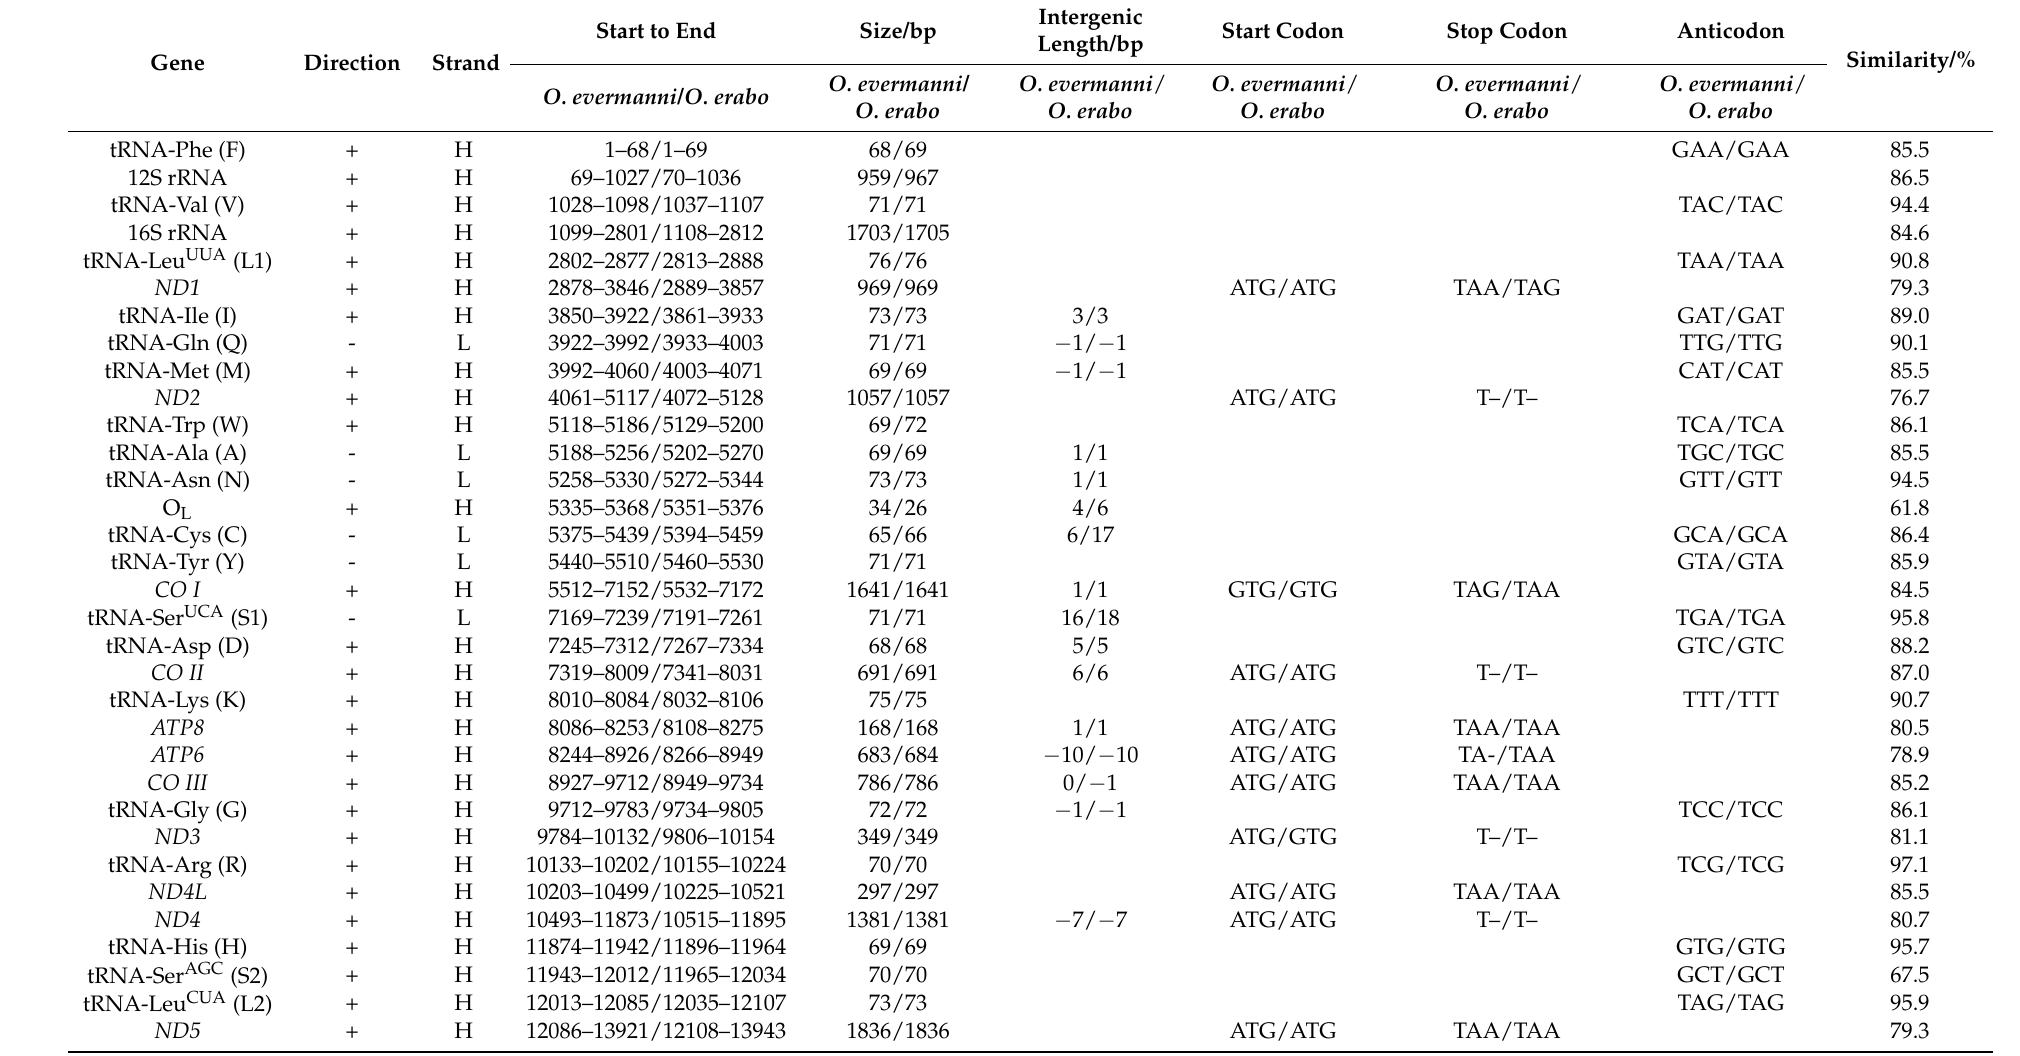
Table 1. Features of the mitochondrial genomes of two Ophichthus